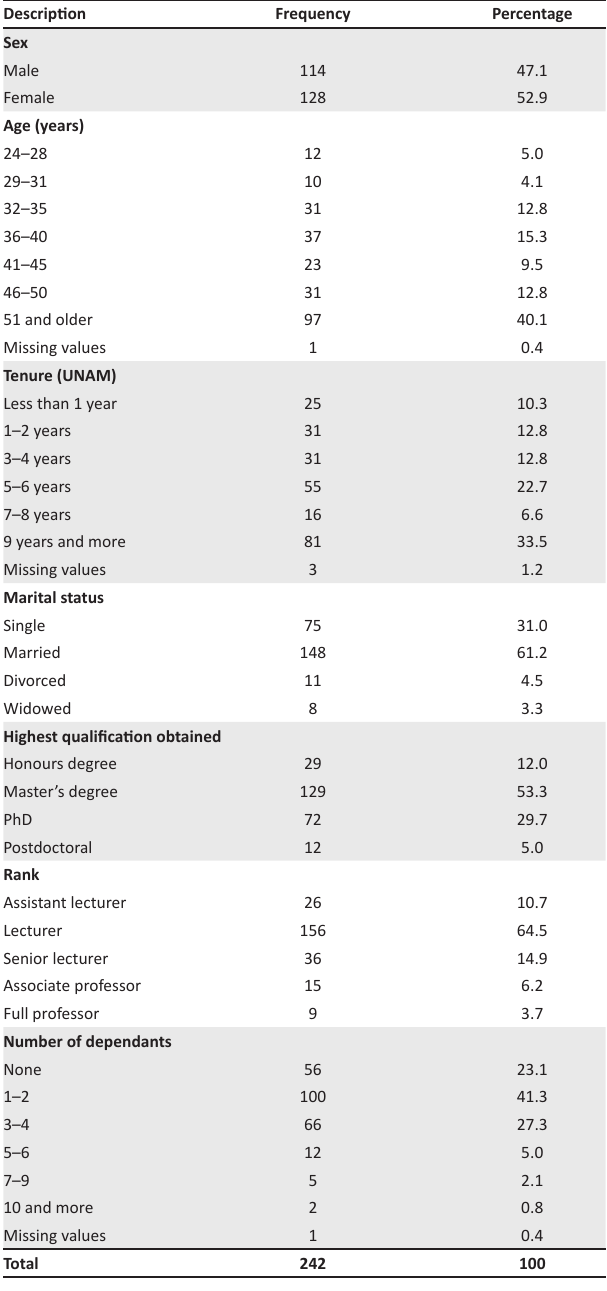
TABLE 1: Biographical details of the study participants.